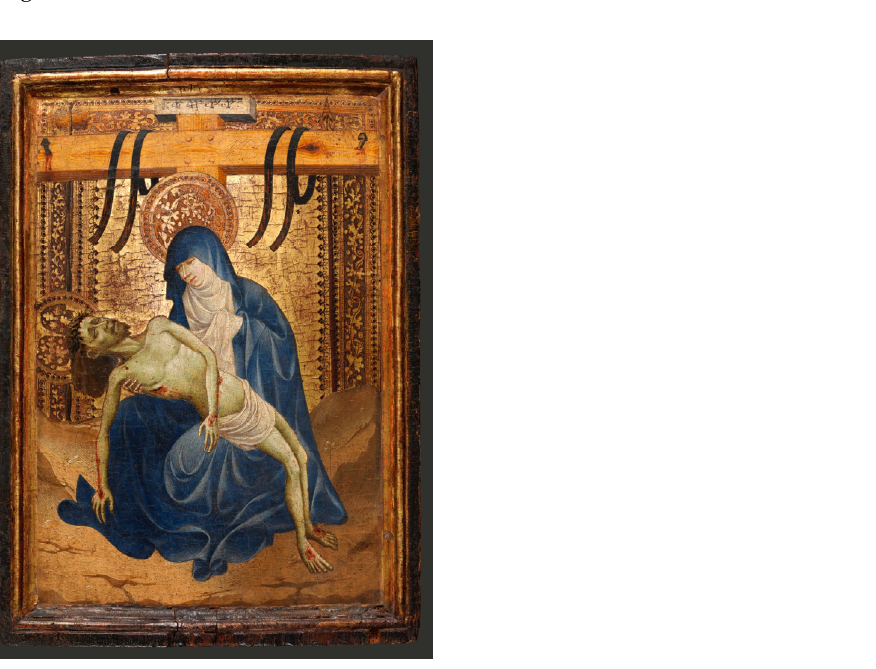
Figure 8. Piety Desplà , Bartolomé Bermejo, 1490, Cathedral of Barcelona. © Cathedral of Barcelona In the Valencian case, the canvas of the Piety with the instruments of the Passion by Gonçal Peris Sarrià (ca. 1420–1430, Musée du Louvre, Figure 9) could be highlighted for the great drama it reflects.